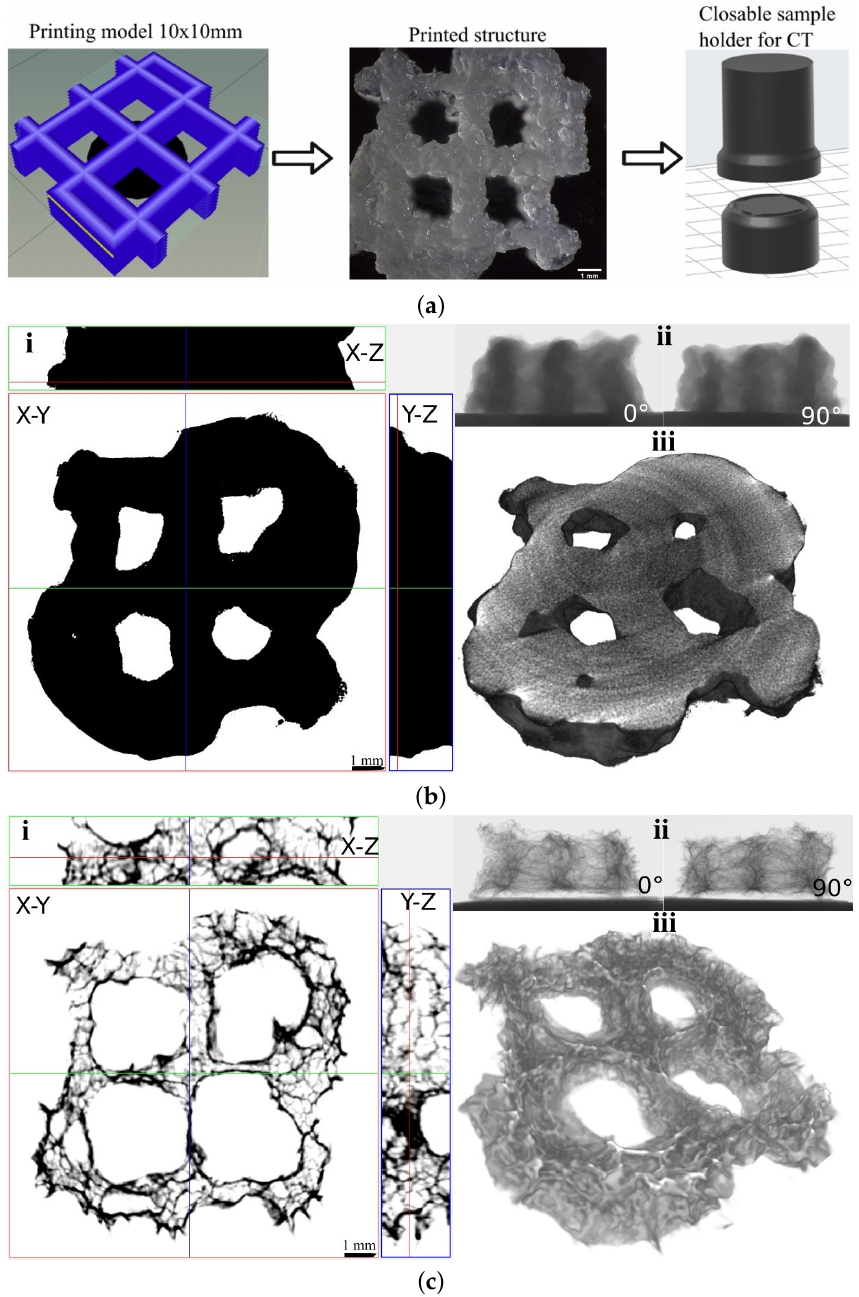
Figure 3. CT analysis of printed structures; ( a ) Scheme of sample preparation, ( b ) As-printed structure, ( c ) Lyophilized structure: i —2D cross-sections in respective planes, ii —X-ray adsorption for either 0 ◦ or 90 ◦ , and iii —3D